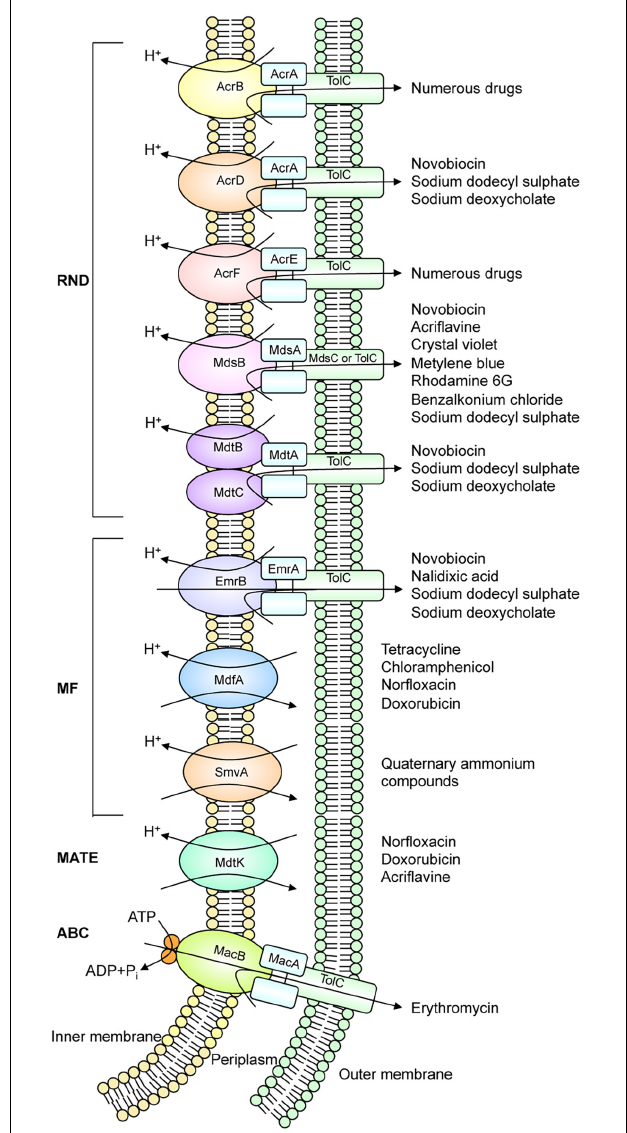
FIGURE 1 | Drug efflux pump systems that exist in Salmonella. Salmonella has at least ten drug efflux